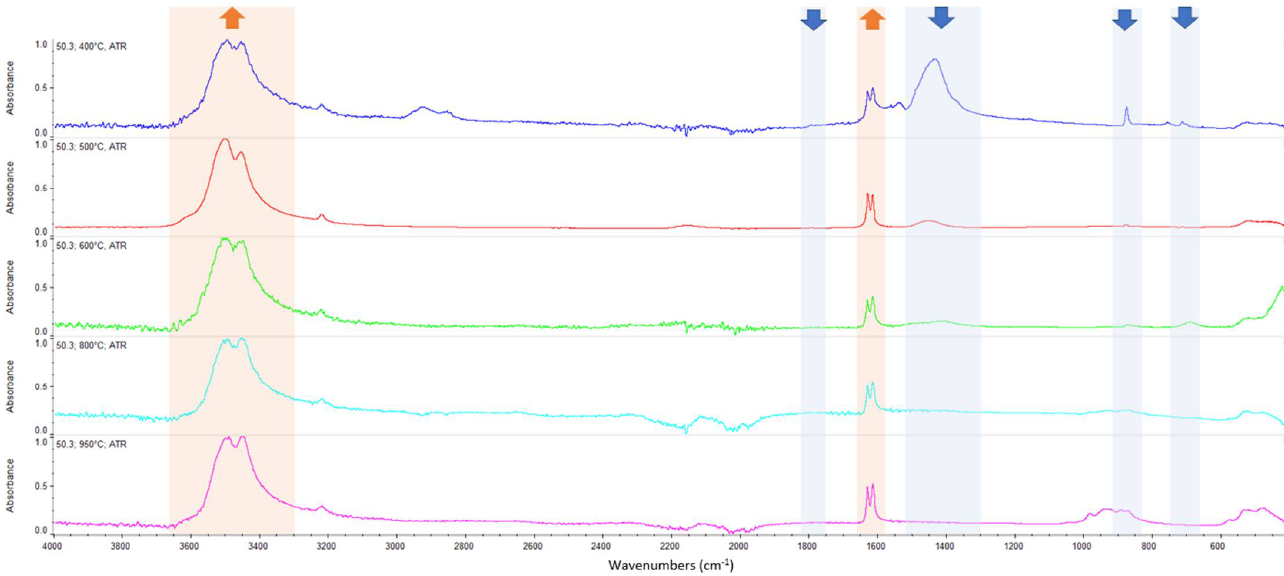
Figure A4. FTIR spectra of ashes of F50.3 at 950 °C (red), at 800 °C (light blue), at 600 °C (green), at 500 °C (purple), at 400 °C (blue).